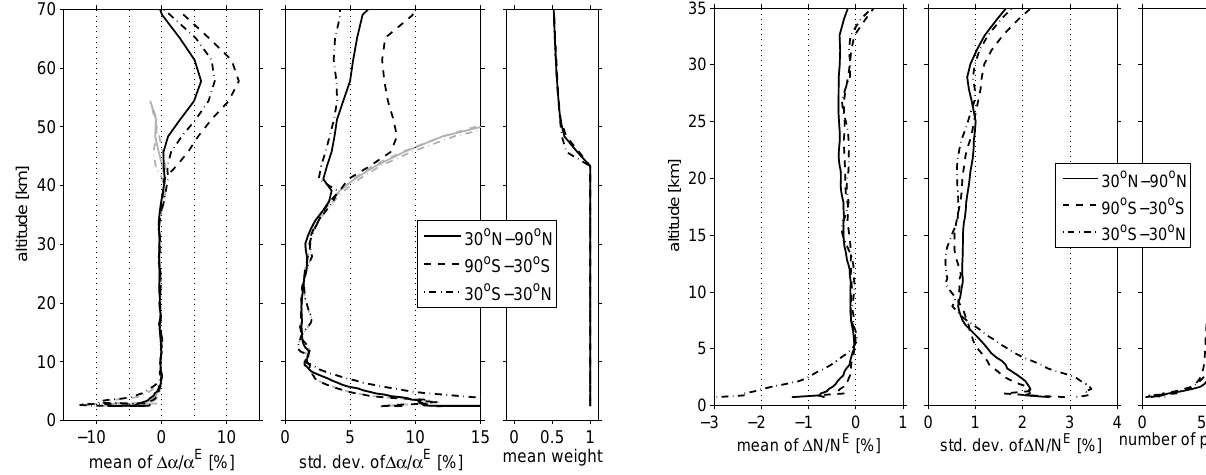
Fig. 10. Comparison of 15327 IGOR (TerraSAR-X) bending an- gle profiles with collocated ECMWF analysis results. The mea- surement period is 24 July to 17 November 2008. The result of statistically optimized bending angles using the MSIS climatology are plotted in black, grey lines mark the corresponding result for the non-optimized (raw) observation. The data is processed by GFZ’s experimental processing system POCS-X using single differenc- ing. Left: mean fractional bending angle error for three meridional zones, 90 ◦ S–30 ◦ S (dashed lines), 30 ◦ S–30 ◦ N (dashed-dotted), 30 ◦ N–90 ◦ N (solid). Center: standard deviation of fractional bend- ing angle error. Right: mean value of the statistical optimization weight.